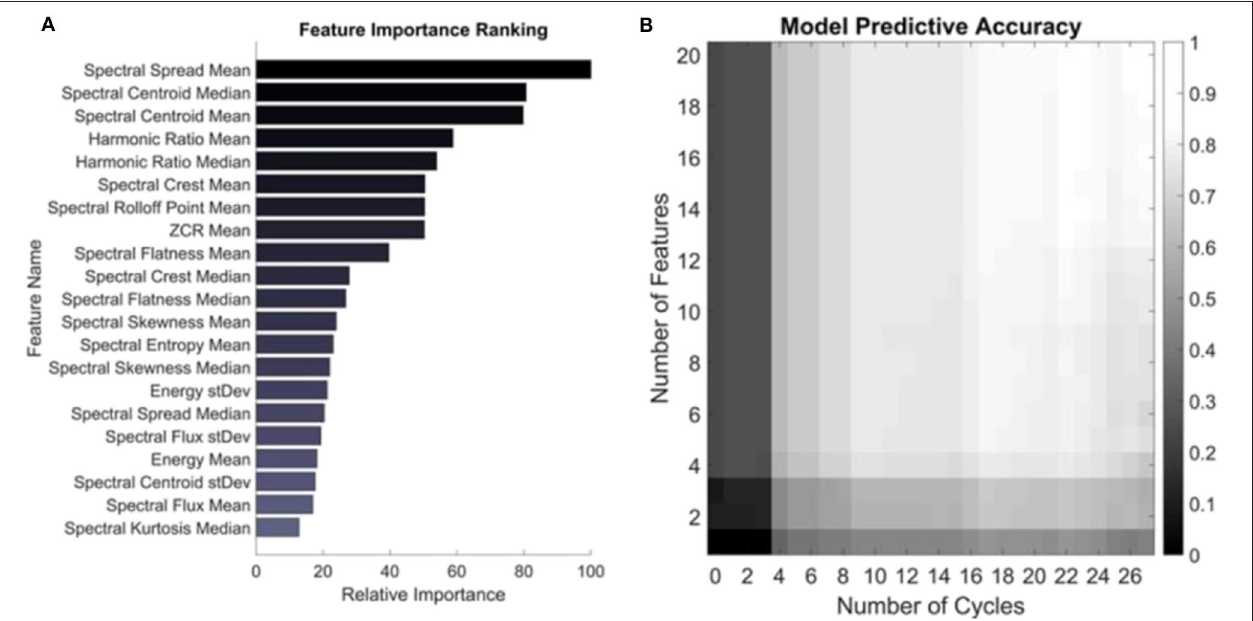
FIGURE 4 | Feature importance and model performance based on number of features and cycles. (A) Features are ranked based on their weighted coefficients as output by the trained logistic regression model. The most important feature was the mean spectral spread. (B) The model was trained on a feature set containing just one and up to 20 of the top features and the accuracy was assessed based on including those features and number of cycles recorded from a subject. The colors represent the average accuracy across all subjects for all permutations of cycle selection for a given set of testing parameters. The maximum accuracy of 80.6% is seen in the top right corner when trained on the 20 most important features and tested on all cycles of a given